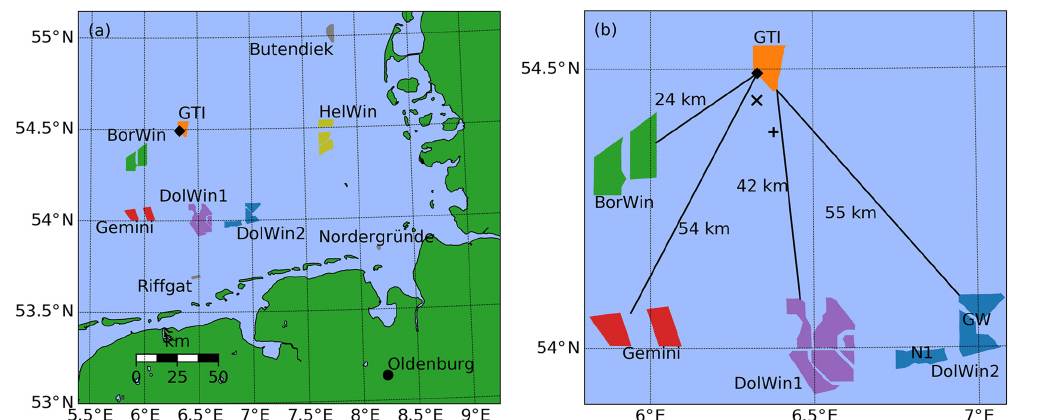
Figure 1. (a) Overview of the considered area in the southern North Sea with wind farms and clusters shown. (b) Close view on GT I and neighbouring wind farm clusters. The position of the lidar in GT I on turbine GT58 (filled (cid:5) ) and the offshore substation (OSS) “Hohe See” ( × ) and the transformer platform “BorWin gamma” ( + ) are marked; distances to upstream clusters are also shown. We measured wakes of all clusters in (b) and exemplary present the wakes of the BorWin and the DolWin2 clusters in this work. Information on the wind farms and full names are listed in Table 1.